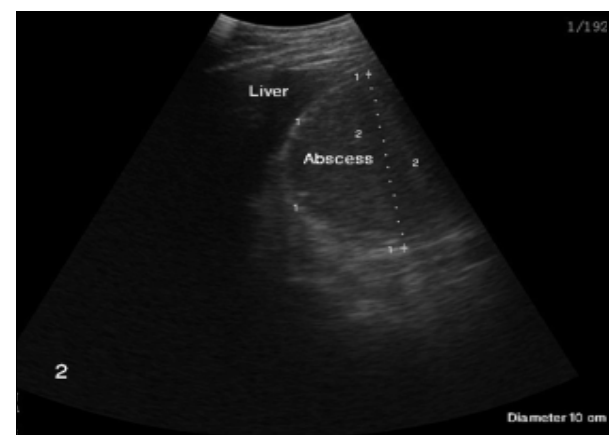
th Figure-1: Ultrasonography of liver at right 10 ICS. shows a large single abscess with 10 cm diameter appears as circum-